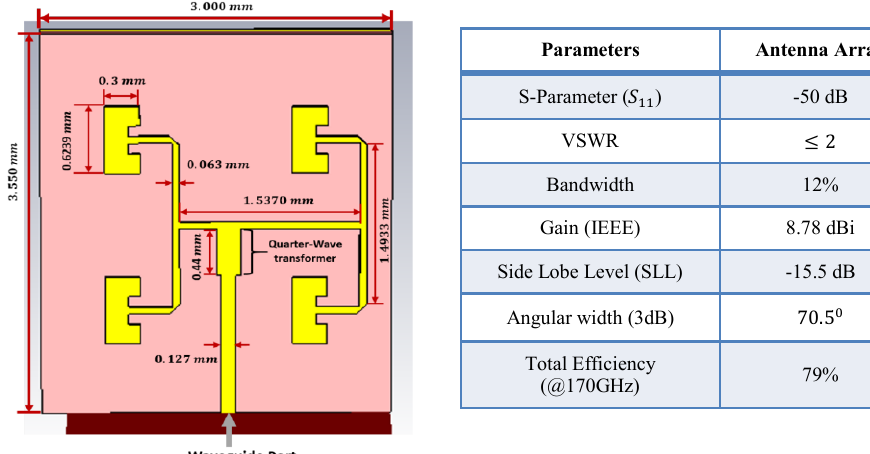
Table 1: Characteristics of antenna array